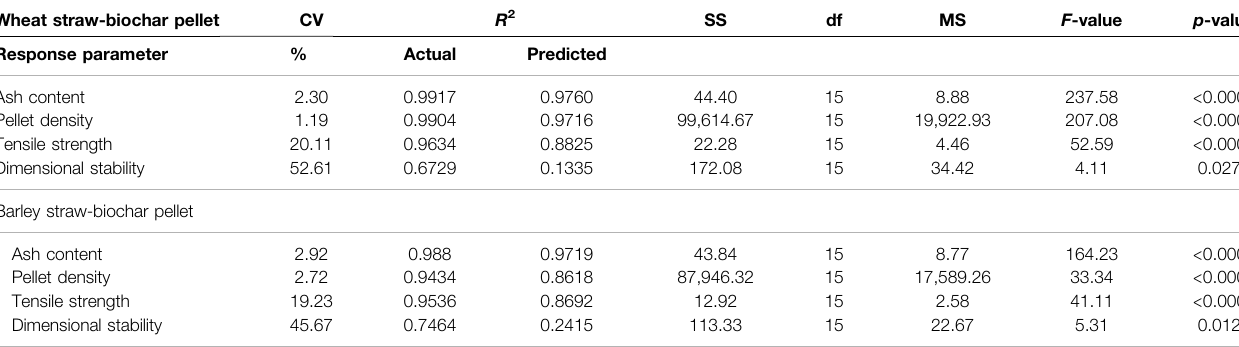
TABLE 6 | Analysis of variance for the quadratic model of UDD responses of wheat and barley straw-biochar pellet at 10% (w.b). Wheat straw-biochar pellet